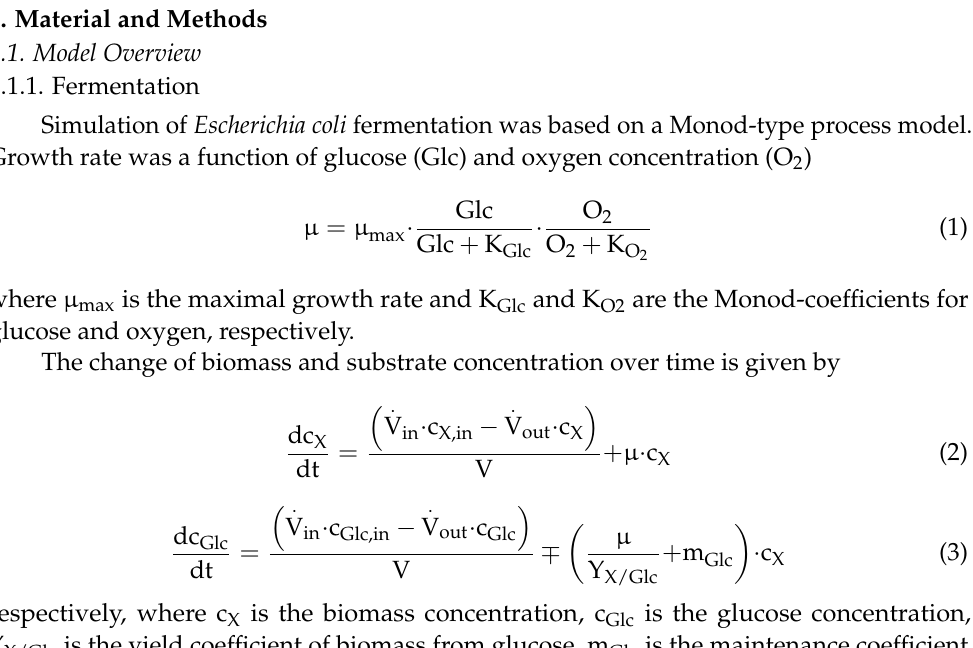
Figure 4. Overview of published and new mRNA manufacturing processes. (RP: Reversed-Phase, MM: Mixed-Mode, IEX: Ion-Exchange). Numbers indicate the order of flow. Three processes are summarized (grey arrow) that represent published process frameworks for the manufacturing of mRNA. The green arrow marks the process sequence as discussed in this